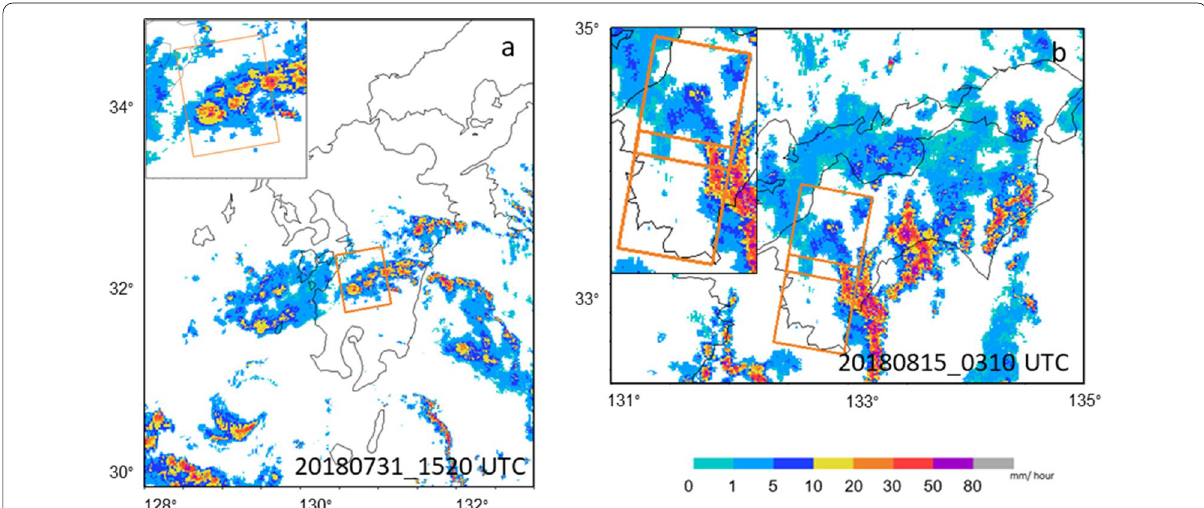
Fig. 1 JMA weather radar observation on a Kyushu at 20180731_1520UTC and b Shikoku at 20180815_0310UTC; we use a convention YYYYMMDD to denote the imaging year, month and date. Orange square denotes the SAR imaging area taken by ALOS-2/PALSAR-2 SM-1 mode